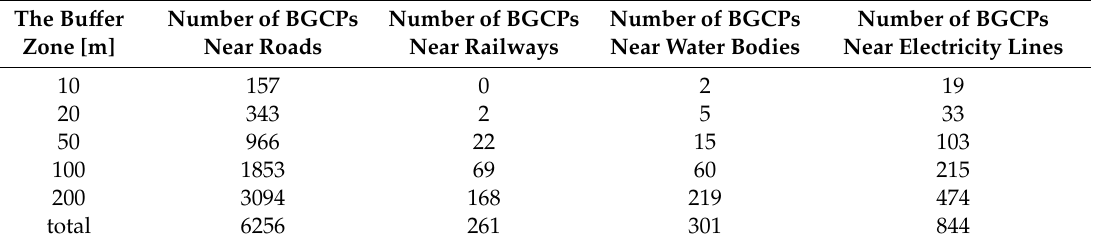
Figure 3. Location of BGCPs: ( a ): Number of BGCPs per CORINE land cover type; ( b ): Number of BGCPs near transport network. Table 3. The number of BGCPs in the vicinity of land cover objects.